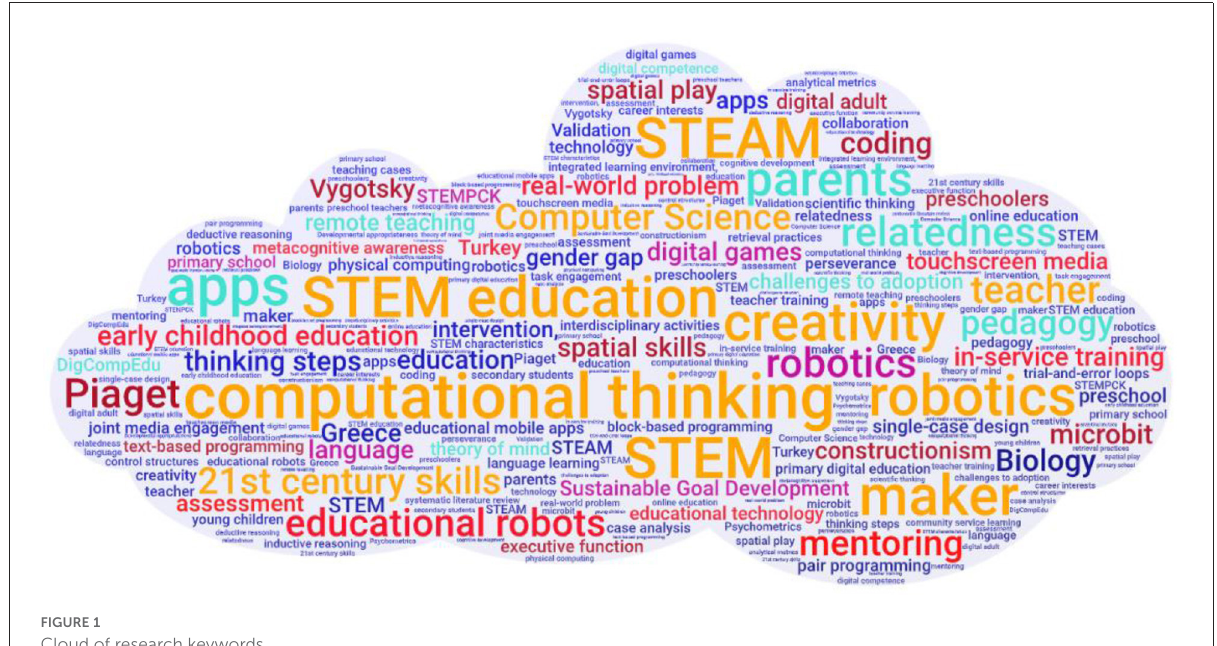
FIGURE1 Cloud of research